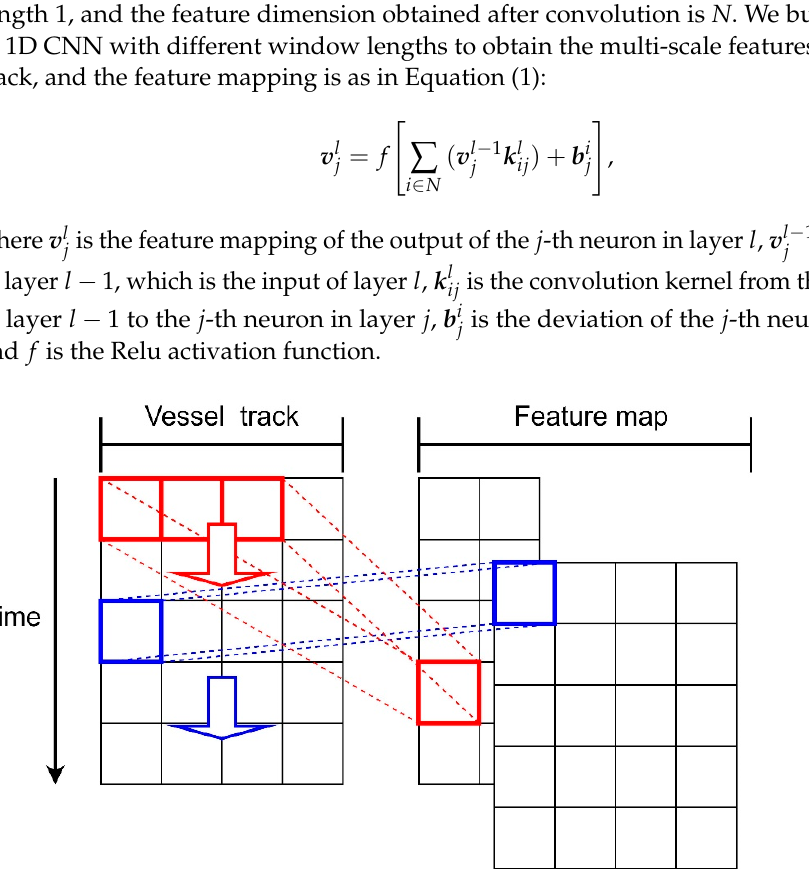
Figure 1. Convolution kernel sliding over time. The red and blue convolutions represent two different window lengths of 1D CNN, and the feature maps are obtained by sliding over the vessel trajectory.